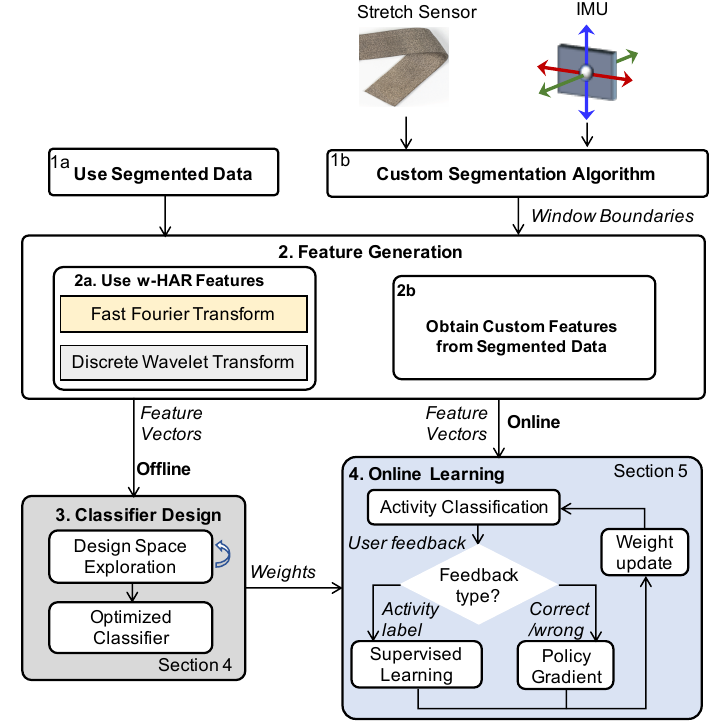
Figure 2. Flow-chart for using the w-HAR data set to test new algorithms or reproduce the results presented in this